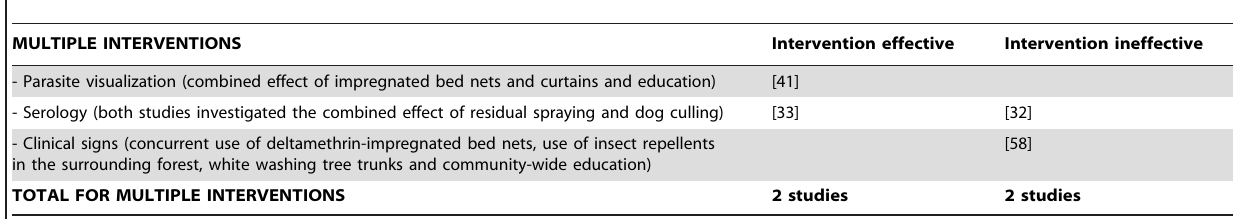
Table 4. Summary table of human outcome measurements for multiple interventions.